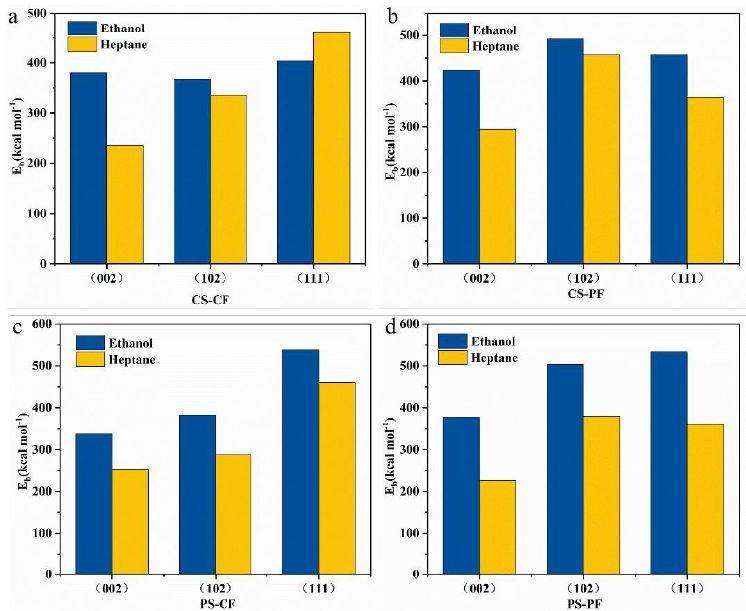
Table 2. The E int (kcal mol −1 ) between the crystal layer and solution layer of the (002), (102), and (111) crystal faces from different models.